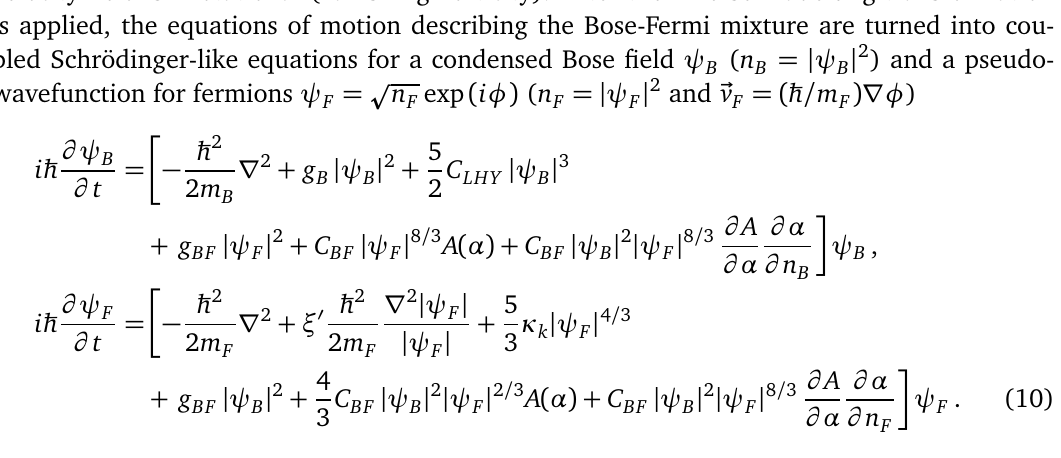
Figure 2: Radial densities (solid and dashed lines for bosons and fermions, respec- tively) for a sequence of Bose-Fermi droplets. for 133 Cs - 6 Li mixture for a and the initial number of bosons (fermions) equal to 1000 (100), 10000 (1000), and 100000 (10000). The horizontal lines are the bosonic and fermionic densities coming from the analysis ignoring the surface effects. Clearly, the surface effects for larger droplets can be